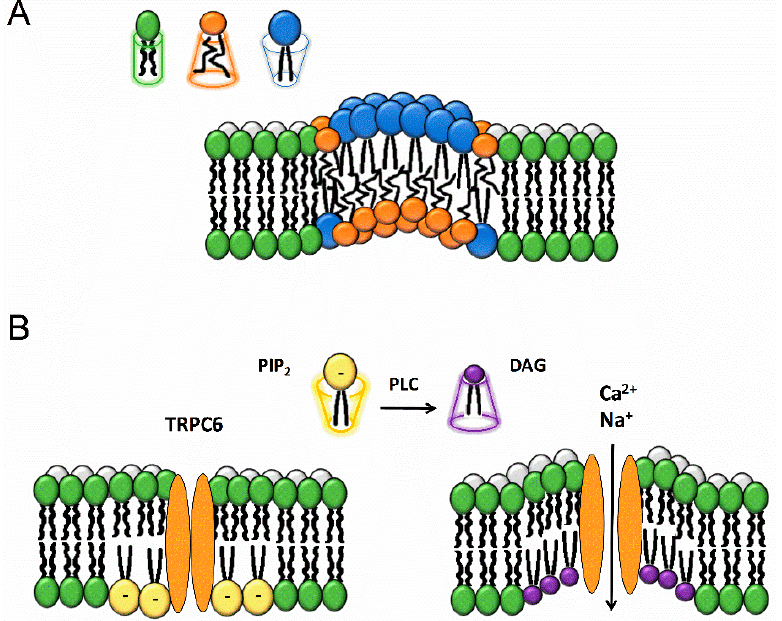
Figure 3. Lipids and membrane bending. ( A ) The membrane curvature can be altered by inserting lipids with specific shapes into the bilayer. Lipids can have a cylindrical (e.g., dioleoylphosphocholine), conical (e.g., dioleoylphosphotidylethanolamine, DAG and cholesterol) or inverse conical (e.g., lysophosphocholine) geometry [99]. Similar lipids tend to self-assemble in dynamic macrostructures depending on their lipid geometry and thus create asymmetric lipid bilayers. The increase in variability of pressure distribution along the membrane leaflets leads to different monolayer torques. The leaflet with the bigger torque bends to restore the system torque balance. ( B ) PLC-dependent breakdown of large-head, charged PIP 2 to small-head, uncharged DAG occurs predominantly in the inner leaflet of the membrane in the close proximity to TRPC6. This causes inner leaflet deflection inducing changes in the curvature, resulting in bilayer stress and TRPC6 channel opening.